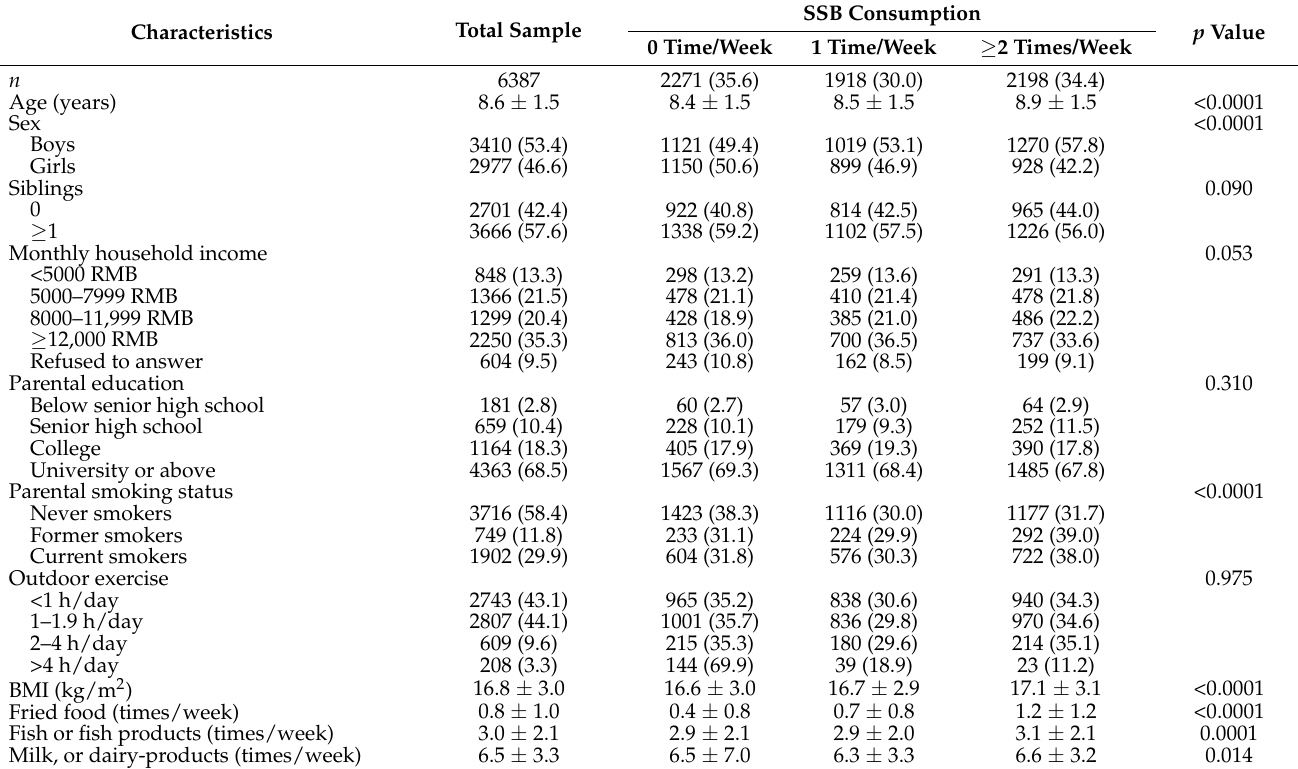
Table 1. Study population characteristics according to SSB consumption.